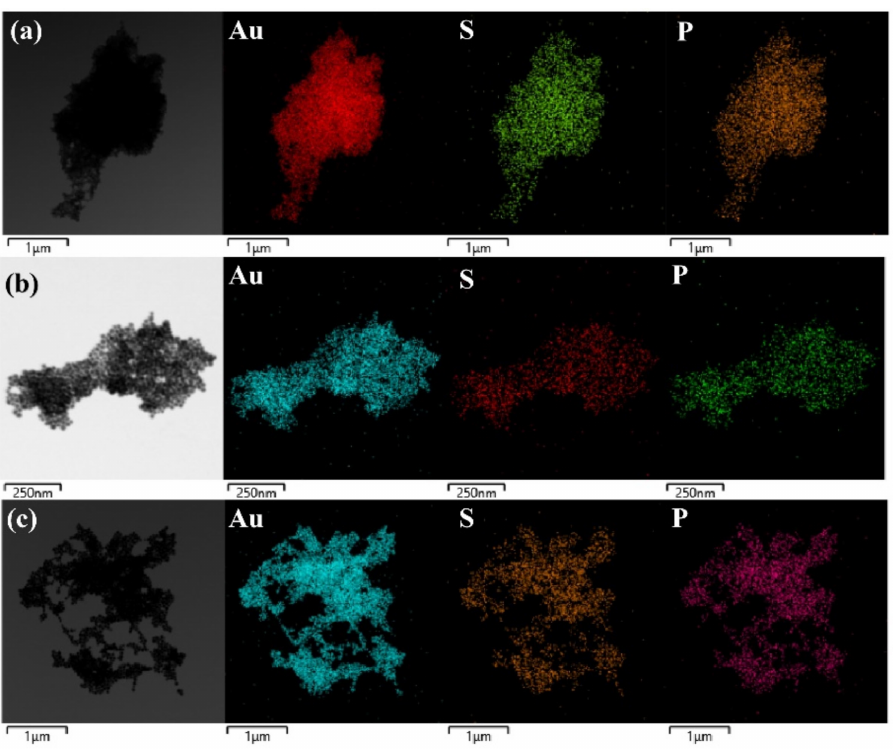
Figure 3. EDS of AET–AuNP chemical sensors S1 ( a ), S2 ( b ) and S3 ( c ) in the presence of 5 mM of glyphosate particles. Au, S, P represents the EDS mapping of AuNP, AET–AuNP and AET-AuNP mixed with glyphosate, respectively.